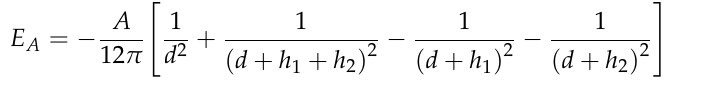
Figure 7. Energy model of London–van der Waals model between two parallel plates.